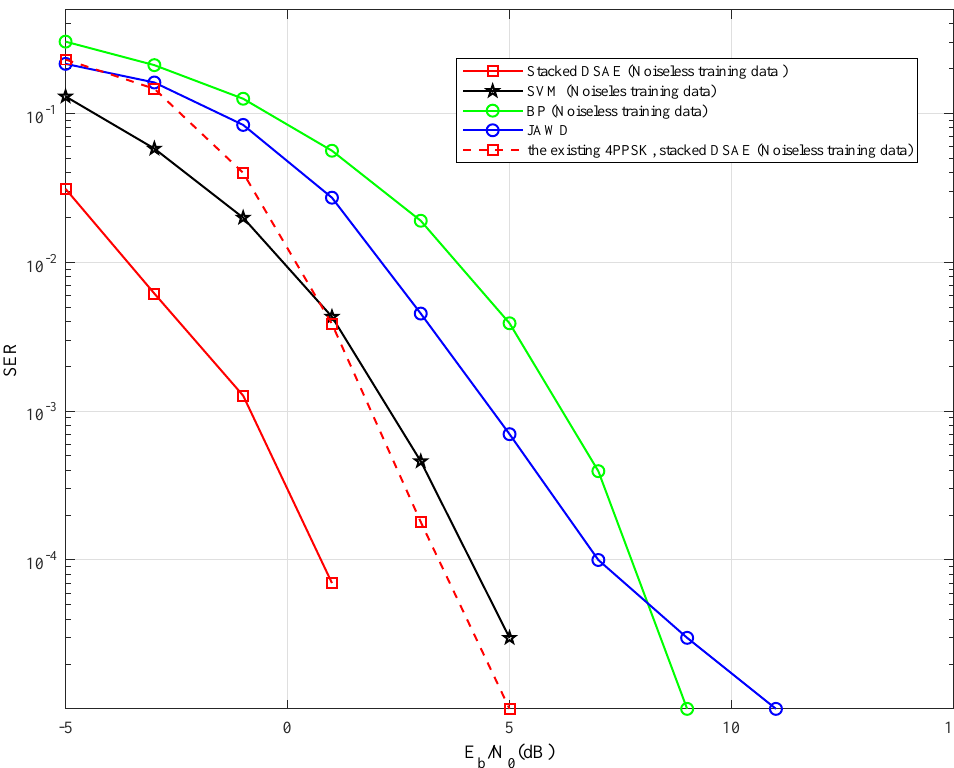
Figure 6. SER Comparisons of the 4PPSK